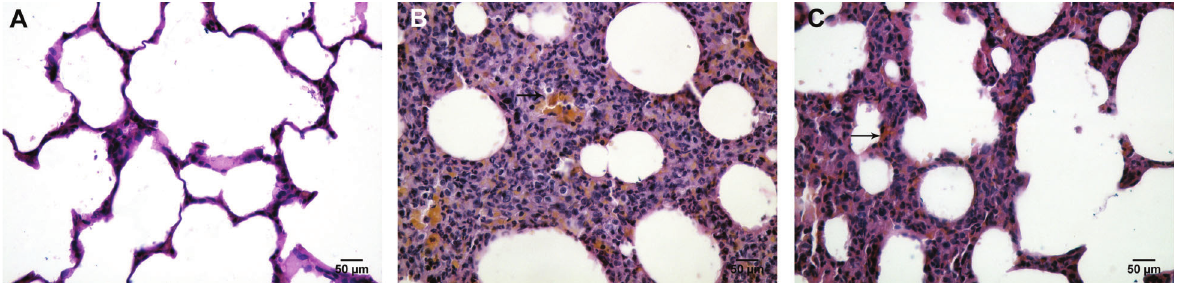
Figure 1. Lung histology detected by hematoxylin and eosin staining. A , Lungs of control animals had a normal appearance. B, After rats received lipopolysaccharide (5 mg/kg, LPS group), edema was severe, with increased red blood cells in the alveolar septum and in fl ammatory cells exiting blood vessels. C , At 30 min after inhalation of sevo fl urane (2.5%; SEVO group), edema was signi fi cantly lower than in the LPS group, with fewer red blood cells in the alveolar spaces and far fewer in fl ammatory cells (magni fi cation, 400 (cid:1) ).